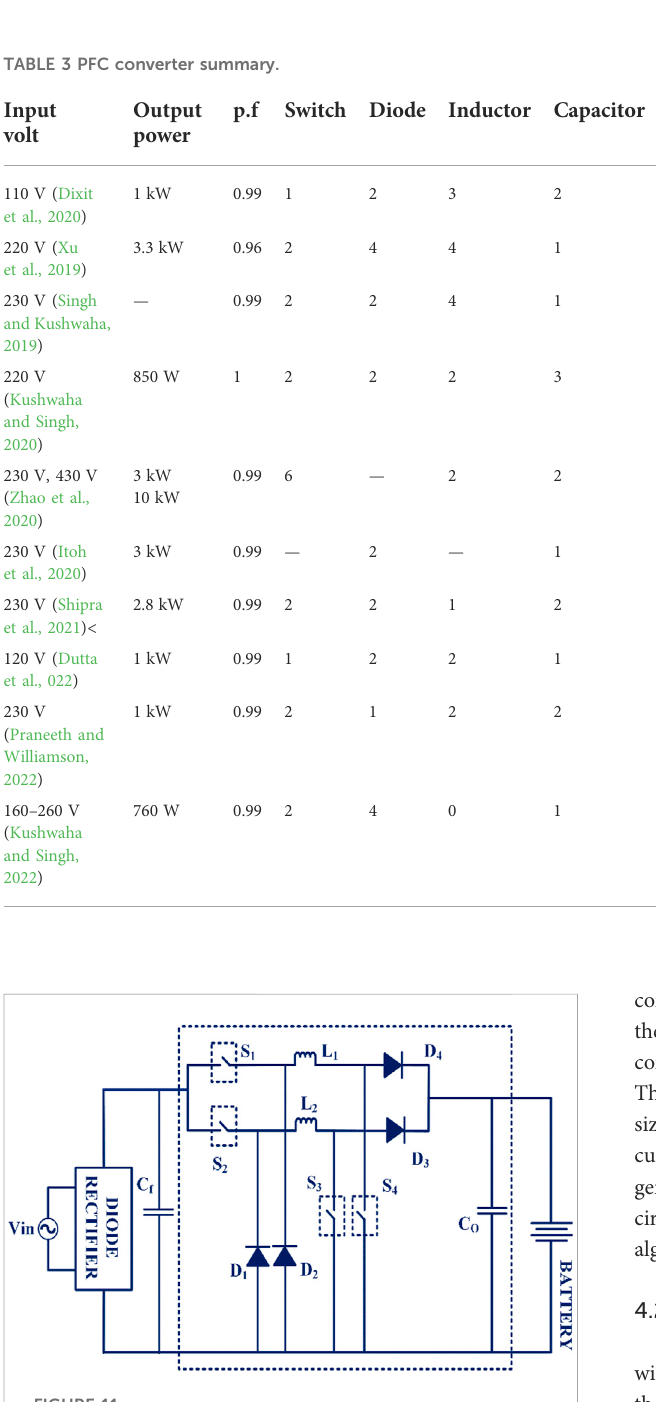
FIGURE 11 Interleaved non-isolated on-board